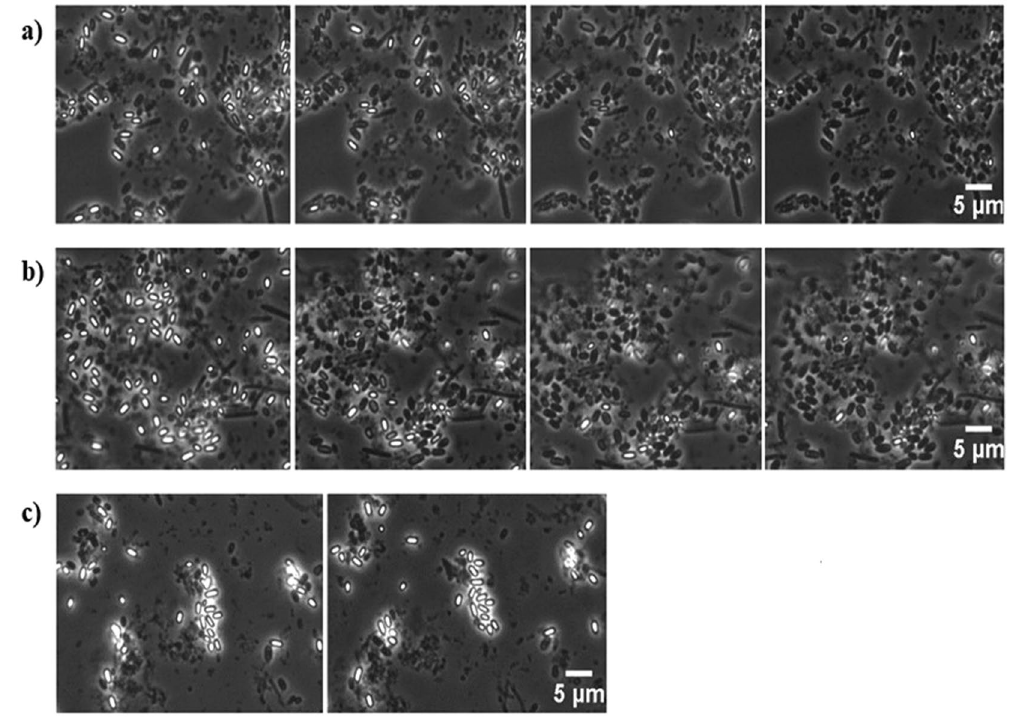
Figure 3. Spore germination of ∆ gerBAC spores and the parental strain visualized with time-lapse phase- contrast microscopy. ( a ) Spores of the parental strain and ( b ) the ∆ gerBAC mutant 5 min, 20 min, 40 min and 1 h (from left to right) after deposition on the agar pad containing the germinants L-ala/L-lact/NaHCO 3 (all at 50 mM). ( c ) Spores of the ∆ gerBAC mutant on an agar pad without germinants 5 min (left) and 1 h (right) after deposition on the pad. Spores of parental strain also remained bright (data not